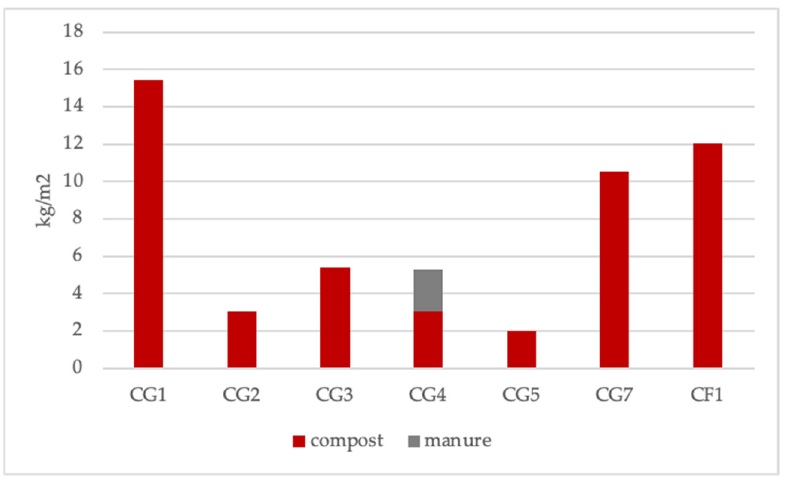
Figure 5. Soil amendments in 2019 per